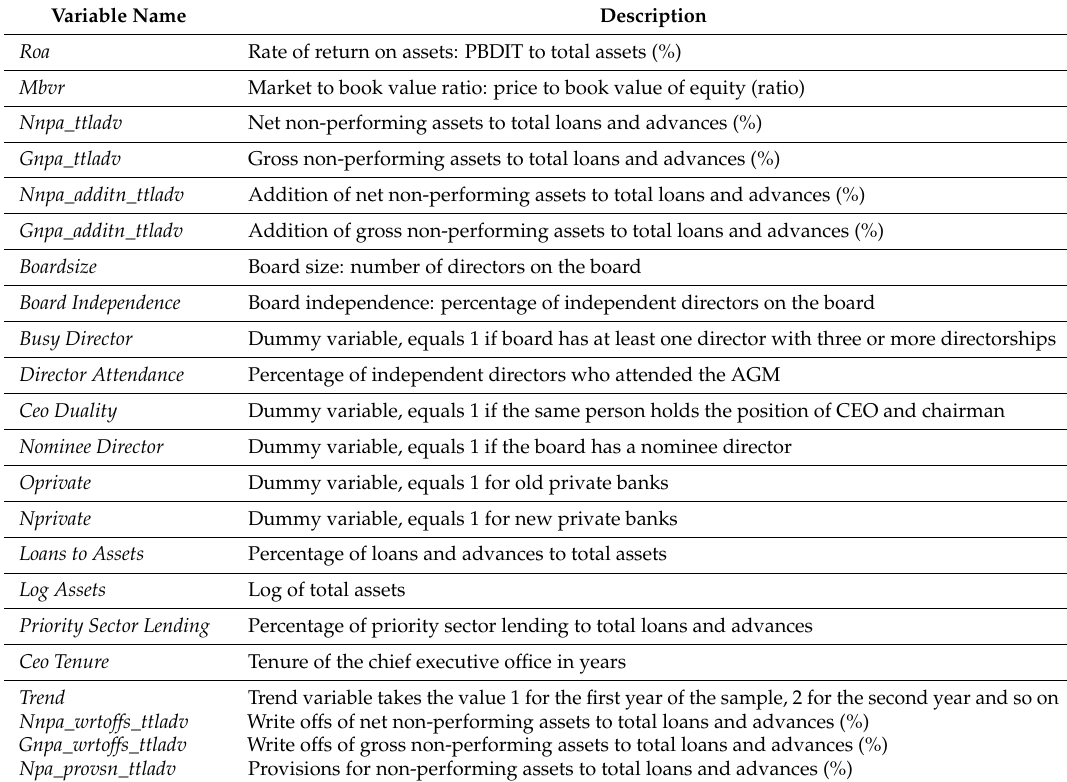
Table 1. Variable Names and